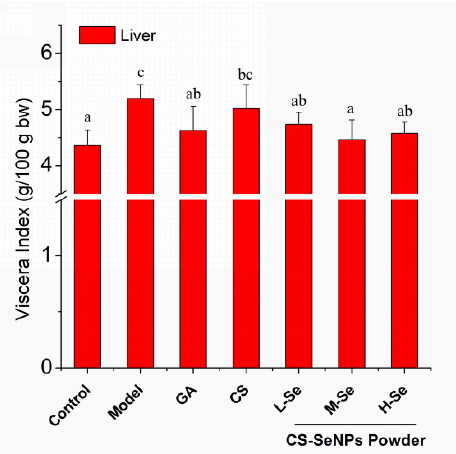
Figure 4. Liver index of KM mice, defined as the ratio of live weight to body weight. a–c Means within a panel with di ff erent letters di ff er significantly.